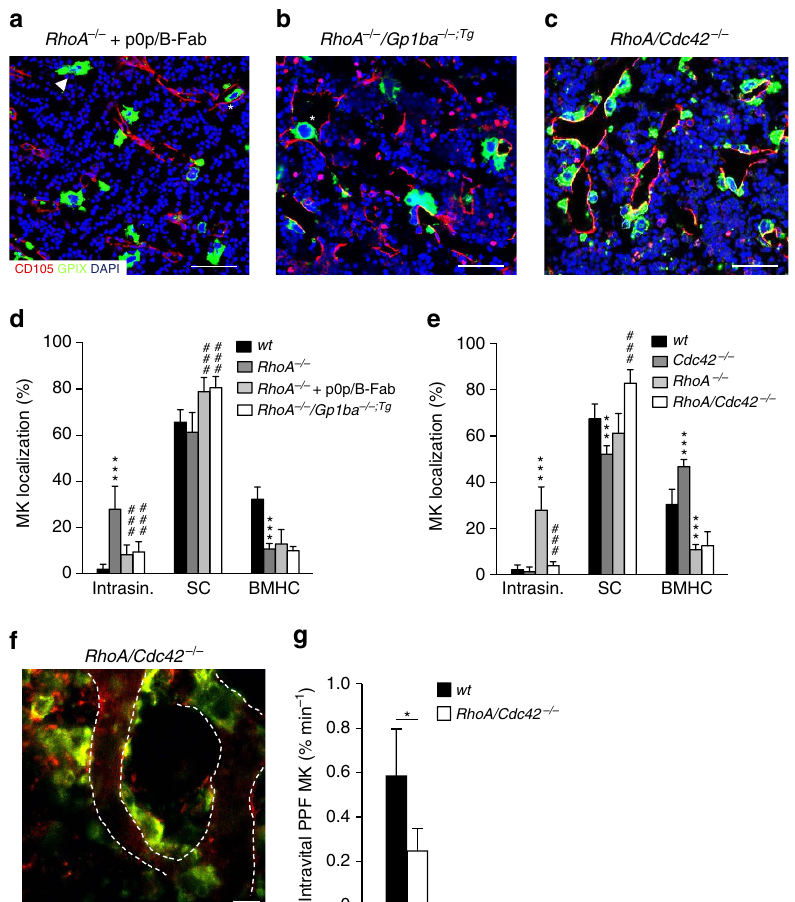
Figure 4 | RhoA restricts GPIb a -Cdc42-driven MK localization and transendothelial migration. ( a – c ) Representative confocal images of immunostained BM of RhoA (cid:2) / (cid:2) mice after treatment with GPIb a -blocking monovalent Fab fragments, p0p/B-Fab ( a ), concomitant lack of the GPIb a ectodomain ( b ), or RhoA/Cdc42 (cid:2) / (cid:2) mice ( c ). n ¼ 4 biological replicates. Scale bars, 50 m m. MKs, proplatelets and platelets are shown by GPIX staining in green colour. Endoglin staining (red) labels vessels. DAPI, blue. Arrowhead indicates MKs in BMHC, asterisk indicates intrasinusoidal (intrasin.) MKs. ( d ) Quantification of MK localization in the BM of RhoA (cid:2) / (cid:2) mice reveals reduced intrasinusoidal localization upon concomitant blockade (light grey) or absence (white) of GPIb a compared to normal RhoA (cid:2) / (cid:2) mice (dark grey) ( n ¼ 9, 3 and 9). Untreated wt is shown in black ( n ¼ 9 biological replicates). ( e ) Quantification of MK localization in the BM of RhoA/Cdc42 (cid:2) / (cid:2) mice reveals reduced intrasinusoidal localization compared to RhoA (cid:2) / (cid:2) mice (light grey) and MK clustering at sinusoids ( n ¼ 4 and 9). Wt (black): n ¼ 10, Cdc42 (cid:2) / (cid:2) mice (dark grey); n ¼ 3. ( f ) Intravital two-photon microscopy of wt (black) and RhoA/Cdc42 (cid:2) / (cid:2) MKs (white) in the skull ( n ¼ 7 and 4). Scale bar, 50 m m. ( g ) Quantification reveals reduced proplatelet-formation (ppf). Bar graphs represent mean ± s.d. ( d , e ) Two-way ANOVA with Bonferroni correction for multiple comparisons; ( g ) Unpaired two-tailed Student’s t -test; * P o 0.05; *** P o 0.001 compared to wt ; ### P o 0.001 compared to RhoA (cid:2) / (cid:2)